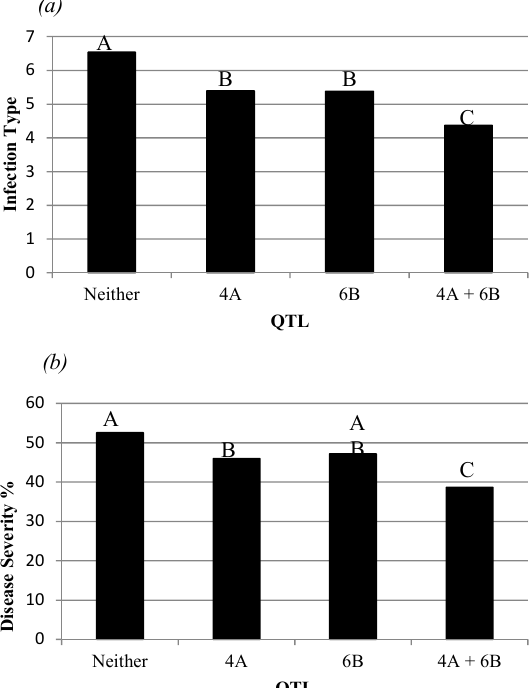
Figure 2. Infection type ( a ) and disease severity ( b ) ratings across all environments for the Finch × Eltan recombinant inbred line population for those lines containing both stripe rust quantitative trait loci (QTL), only the 4A QTL, only the 6B QTL, and neither.